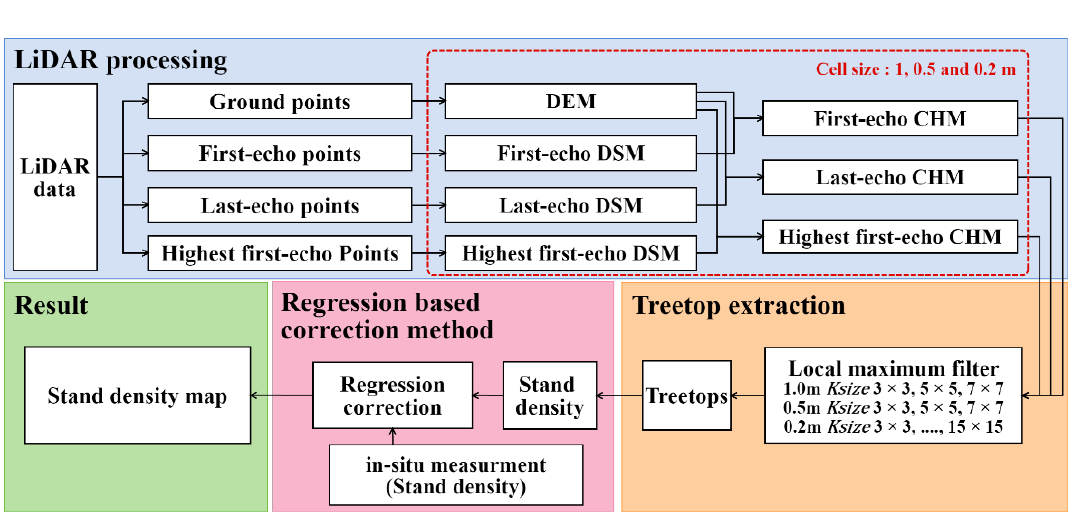
Figure 2. Stand density estimation procedure.